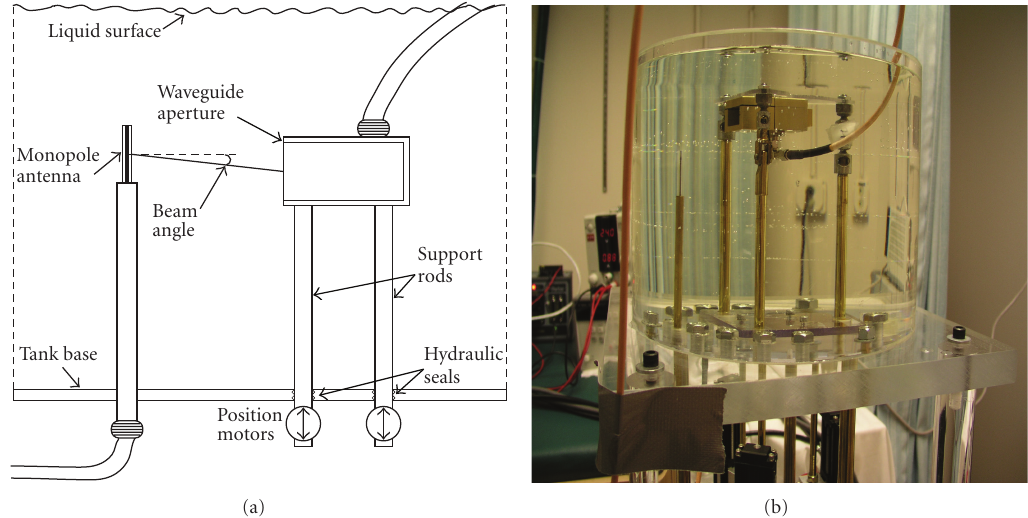
Figure 3: (a) Schematic diagram and (b) photograph of the setup for beam pattern measurement involving a 3-point support (3PS) me- chanical steering system with the aperture reference waveguide antenna positioned approximately 6cm from the monopole